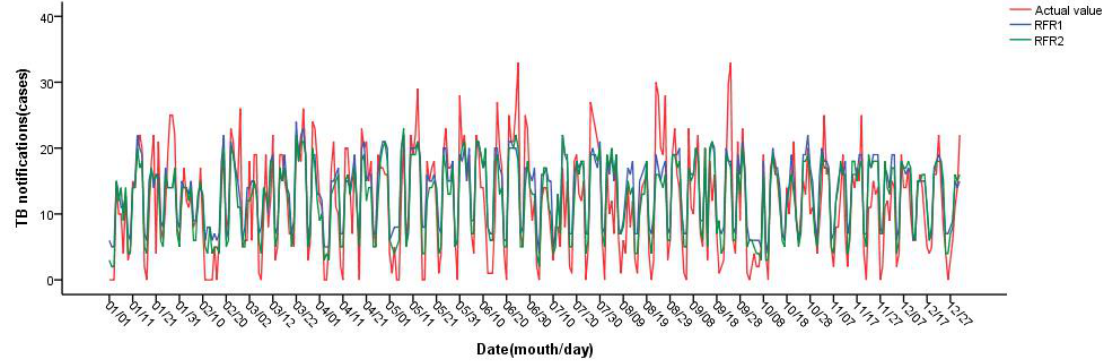
Figure 5. Prediction results of random forest regression.